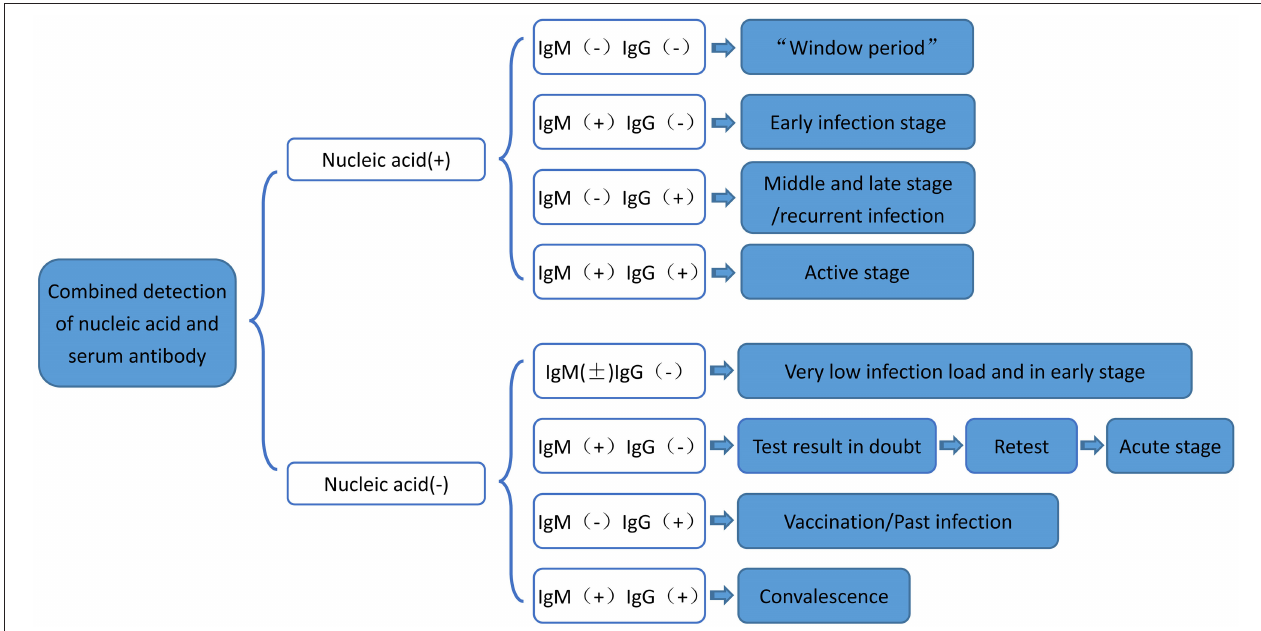
FIGURE 7 | Flow chart of serum-specific antibody binding RT-PCR nucleic acid detection. RT-PCR, Real-time fluorescence quantification reverse transcriptase; COVID-19, 2019 novel